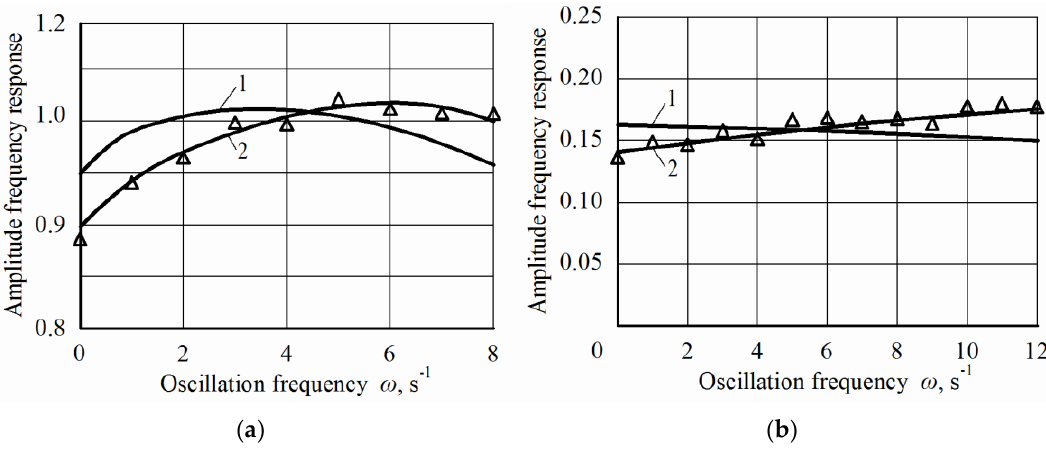
Figure 5. Theoretical (1) and experimental (2) amplitude-frequency response of the relative bearing 𝜑 of the tractor when reacting to the external impacts in the form of variations of the turning angle 𝛽 of the swath header ( a ) and in the form of variations in the turning angle of the driven wheels 𝛼 of the tractor ( b